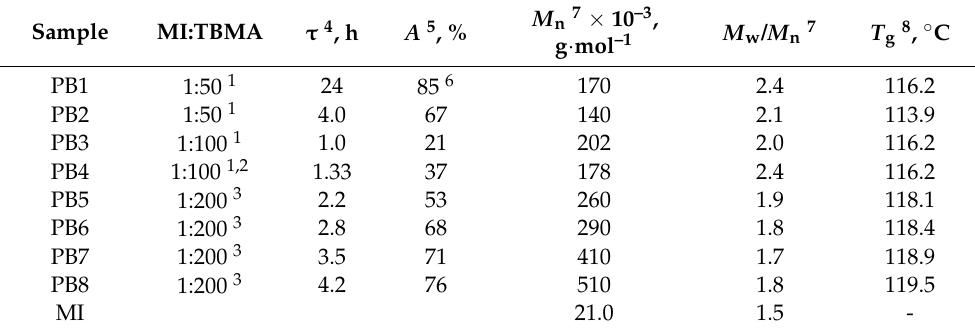
Figure 3. ln([M] 0 /[M] t ) plot vs. time in solution polymerization (33 vol%) of TBMA in anisole from AGET mechanism, molar ratio [MI]:[CuCl 2 ]:[Sn(EH) 2 ]:[dNbpy] = 1:1:1:3.